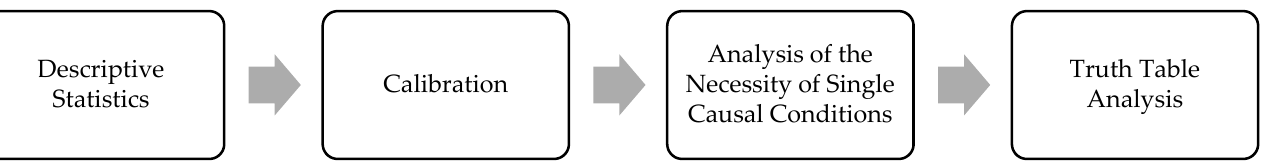
Figure 2. Flow chart of data analysis .